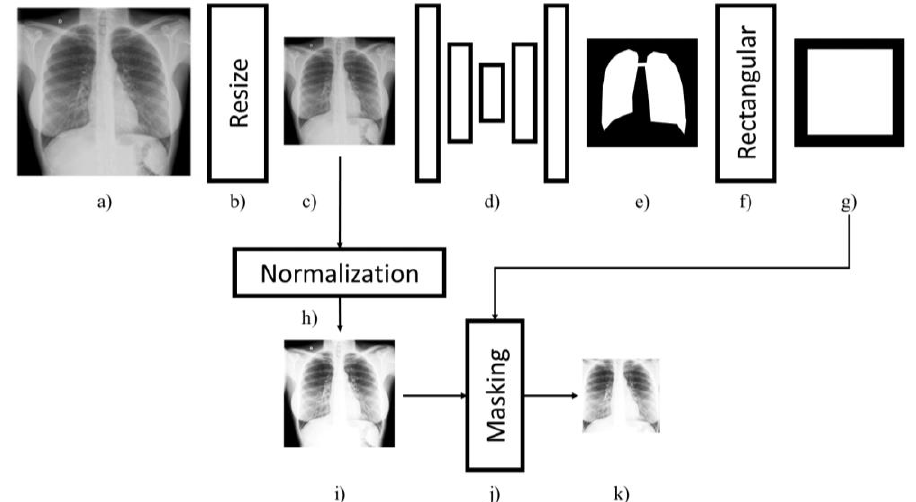
Figure 2. The pre-processing stage. The original image ( a ) is properly resized limiting the maximum dimension to 1000 pixels but maintaining its original aspect ratio ( b ). The resized picture ( c ) is then processed by the U-Net model ( d ) to extract a binary mask ( e ) indicating where the lungs are located. To define the final cut ( g ), the binary mask ( e ) is framed by the smallest rectangle that contains the lungs ( f ). The resized picture ( c ) is normalized by mean and variance ( h , i ) and finally cropped ( j ) using the computed rectangular cut to obtain the final picture ( k ).